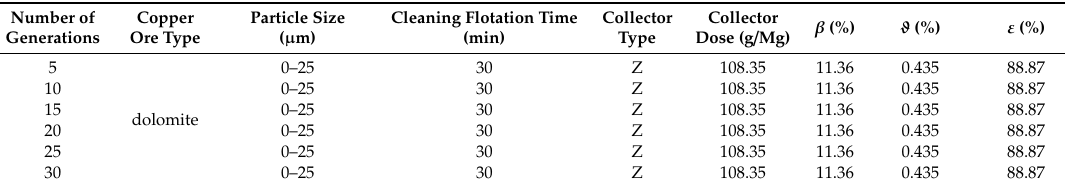
Table 11. A summary of the results of the copper ore flotation process optimisation in the Jameson cell taking the gradual development of the algorithm into account (E—aqueous solution of ethyl sodium